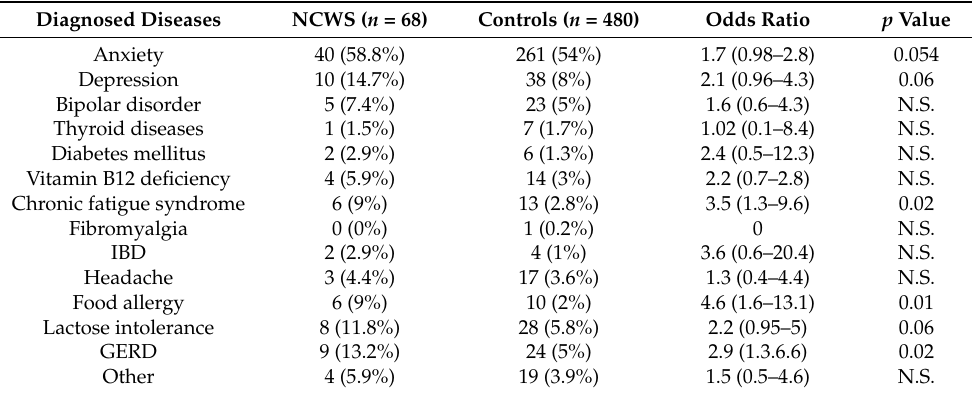
Table 2. Diseases previously diagnosed in subjects with self-reported NCWS and in controls. Number and percentage are given.